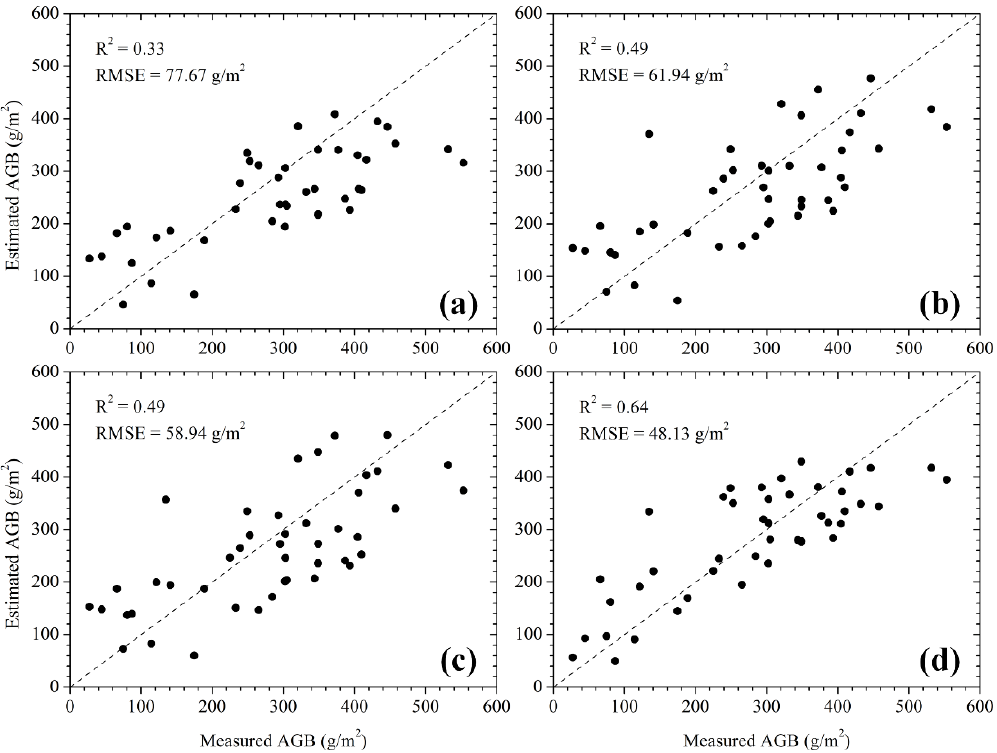
Figure 5. Results of the leave-one-out cross-validation. ( a – c ) Cases from the function regression between the field-measured aboveground biomass (AGB) measurements and the NDVI, SAVI and EVI, respectively. ( d ) Gaussian process regression.